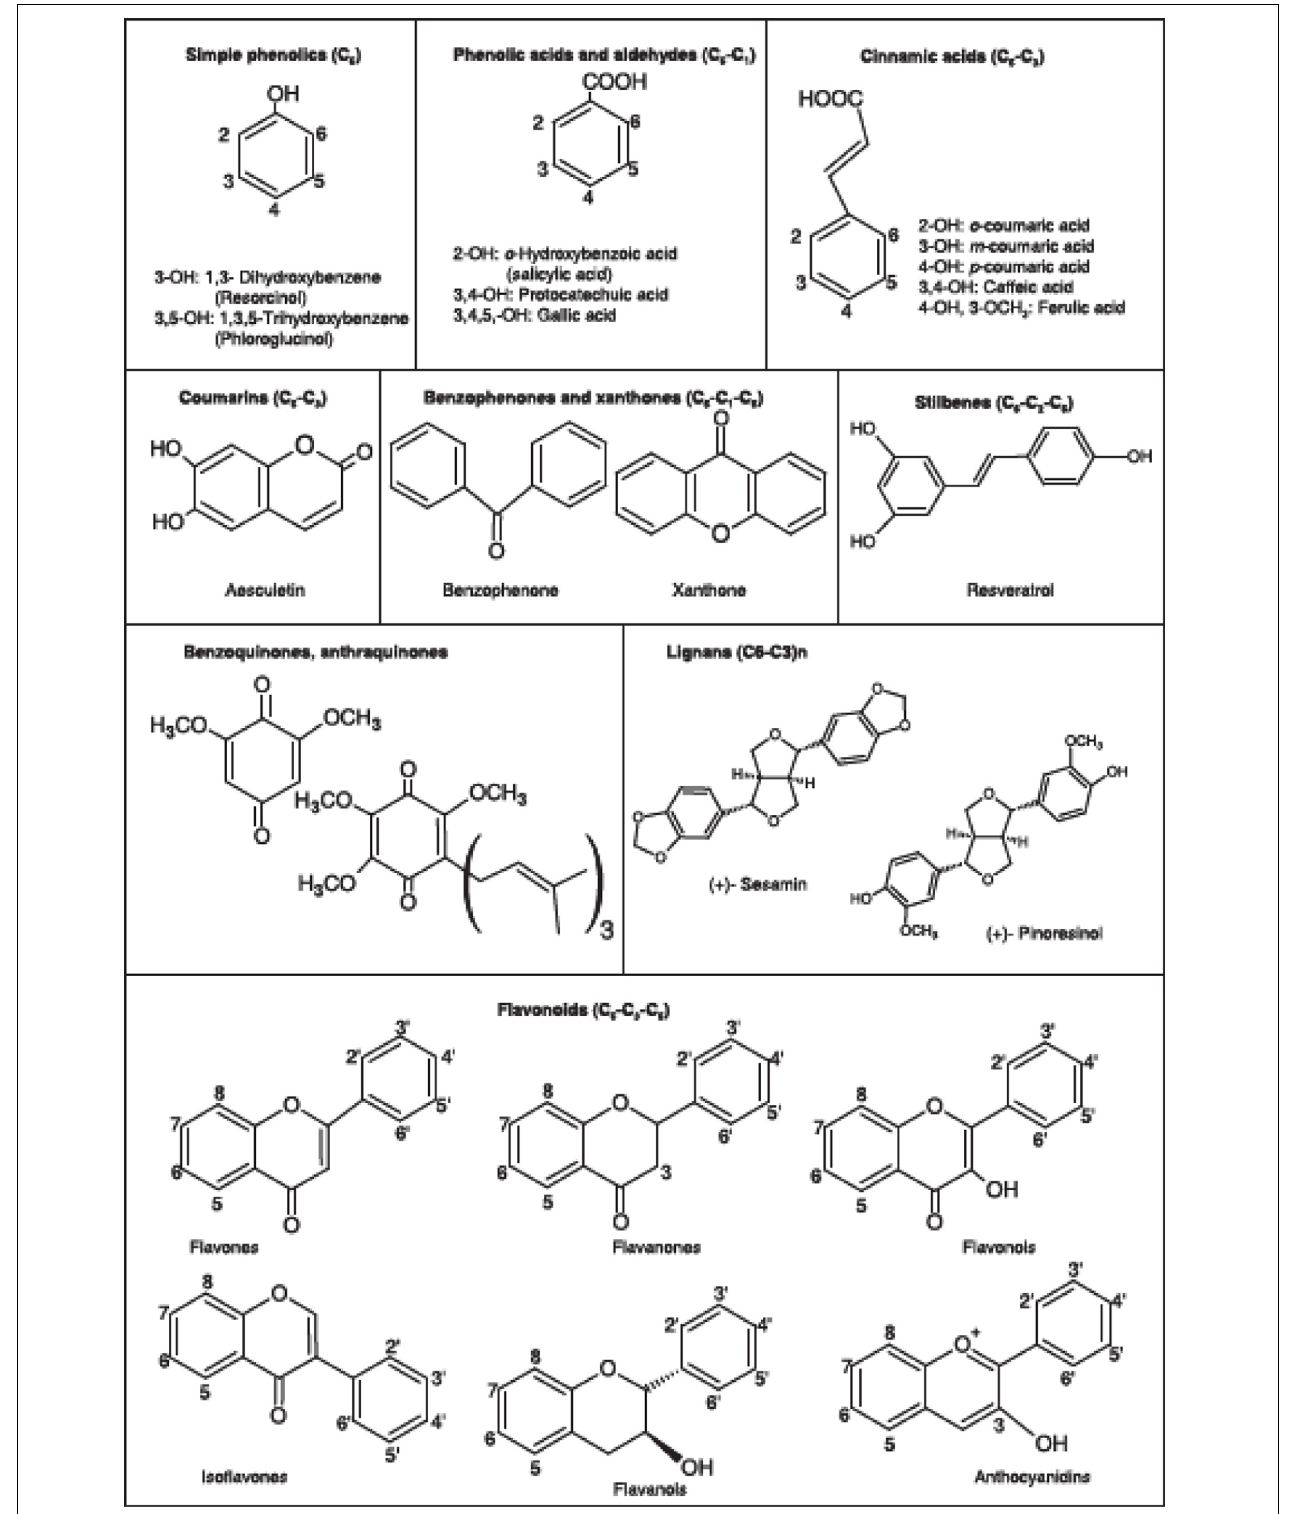
FIGURE 1 | Phenol derivatives (C6) commonly found in industrial wastewaters or fractions isolated from vegetal sources. Representative examples are indicated under the general chemical structures (Soto et al., 2011) (with permission).